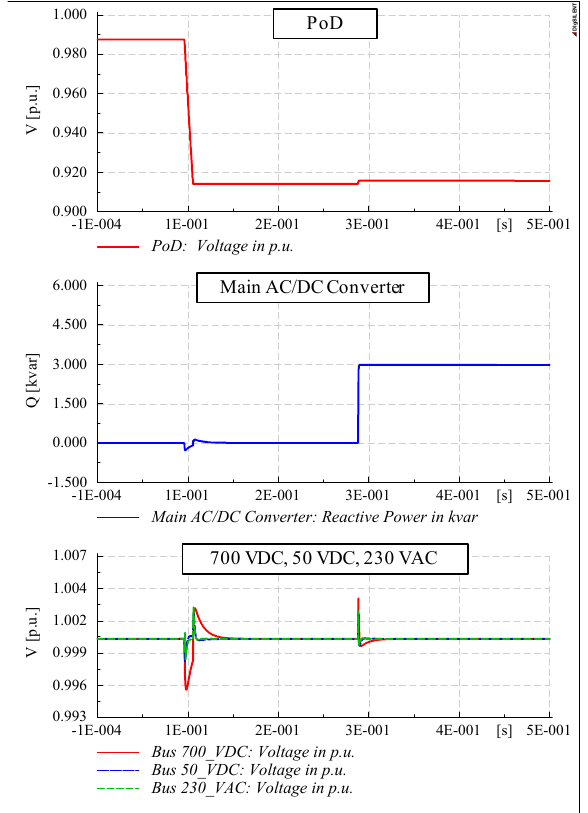
Figure 8. Voltage regulation at output buses during network voltage perturbations and Q/V stabilizing function provision.